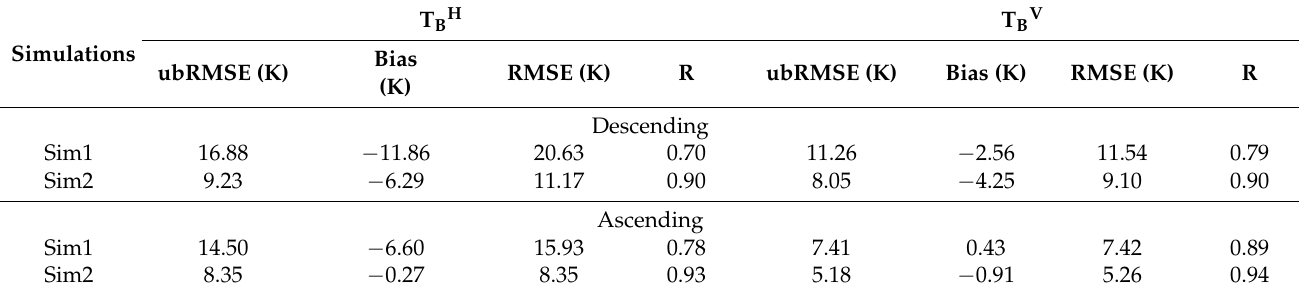
Figure 6. Time series of the SMAP ( a , c ) T BH and ( b , d ) T BV measurements and simulations per- formed for the SMAP footprint during the SMAP descending ( a , b ) and ascending ( c , d ) overpasses between August 2016 and July 2017. Sim1: two-stream emission model configured with SMAP parameterization; Sim2: Zheng’s parameterization. Table 1. Error statistics estimated between the SMAP measured and simulated T B p performed for the SMAP footprint between August 2016 and July 2017 for the SMAP ascending and descending overpasses. Sim1: SMAP parameterization; Sim2: Zheng’s